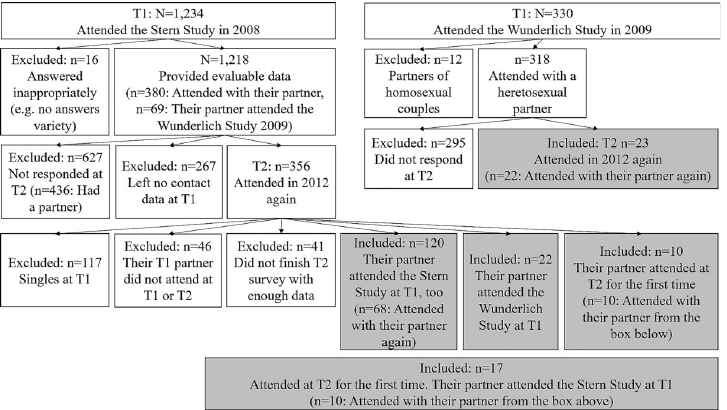
Fig 2. The figure depicts the exclusion criteria and the number of participants affected by each (if not already excluded for a preceding reason). Participant flow. The figure shows that the main data source of the 192 partners used in the current study were the 120 partners who took part in the Stern study as well as in the follow-up four years later. The included study subjects are marked in grey. No information on the drop-out due to starting but not finishing the T1 surveys could be